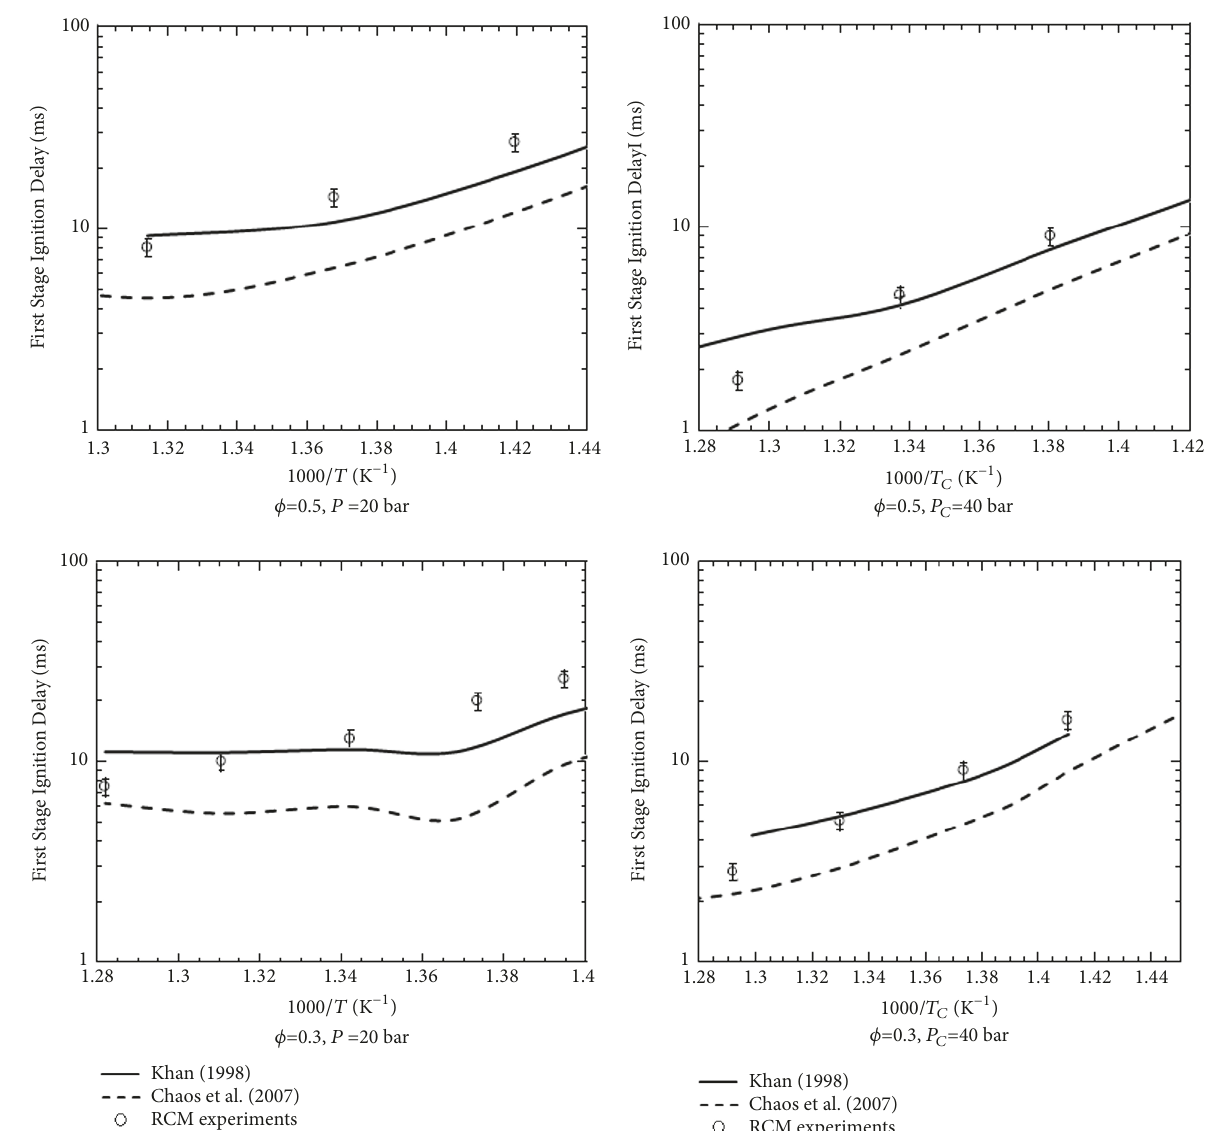
Figure 14: Comparison of experimental and simulated first-stage ignition delay times. Experimental data is from Kukkadapu et al. [23]. Surrogate simulations were carried out using Khan [32] and Chaos et al. [12] surrogates using the mechanism of Samimi Abianeh et al. [19].